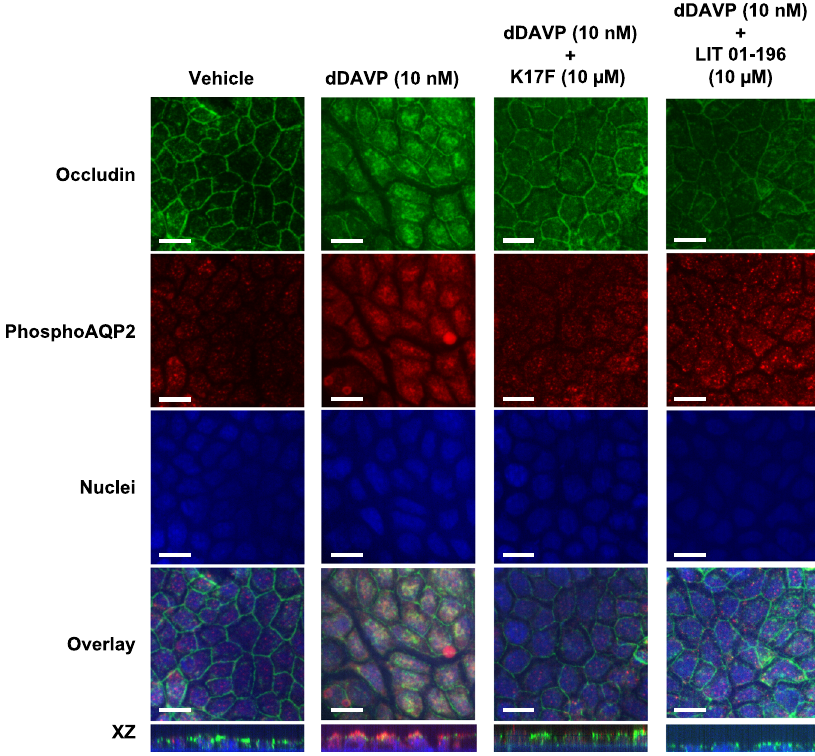
Fig. 3 Effect of K17F and LIT01-196 treatment on dDAVP-induced phosphorylation of aquaporine 2. mpkCCD cells were grown on transwell fi lters for 5 days. After 24 h of starvation, cells were treated with vehicle or 10 nmol/l of dDAVP with or without 10 µ mol/l of K17F or LIT01-196. Representative immuno fl uorescence images of three independent experiments are shown in XY and XZ plans and represent the immuno fl uorescence staining with an anti-occluding (green) and an anti-phospho-AQP-2 (red) and the staining of the nuclei with DAPI (blue). Bar scale = 20 µ